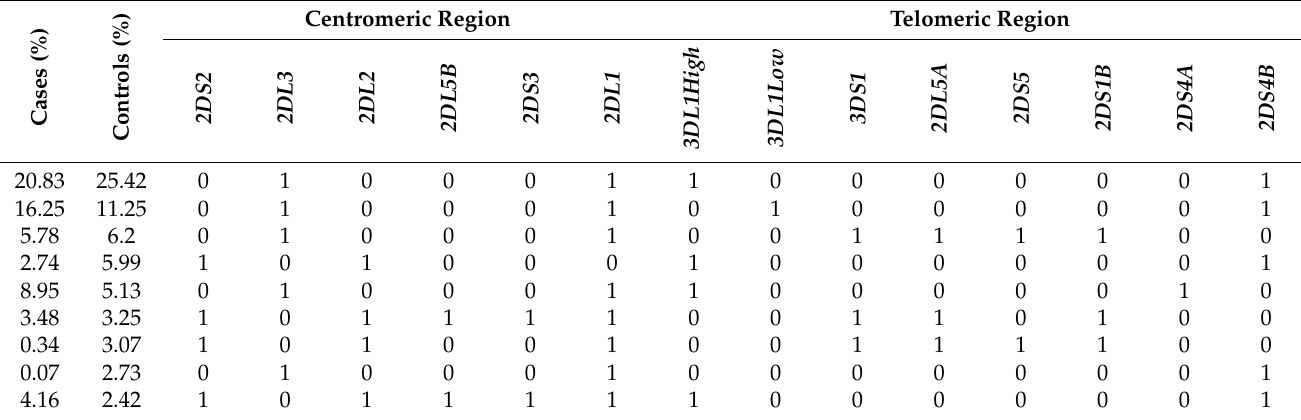
Table 4. Estimated KIR haplotypes frequencies in cases and controls.